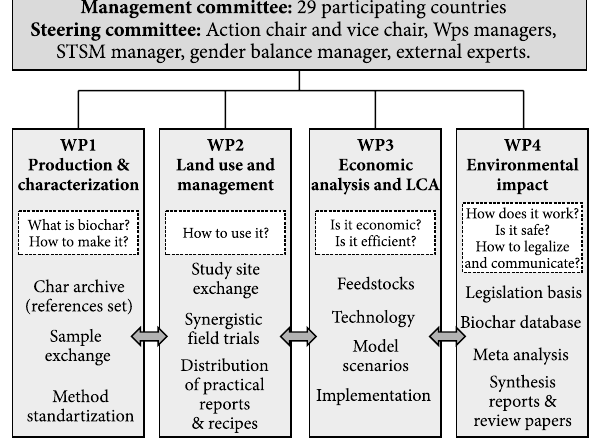
Fig. 1. Organization of EU COST Action TD1107: Biochar as option for sustainable resource management. For more details see the website of the European Biochar Research Network: